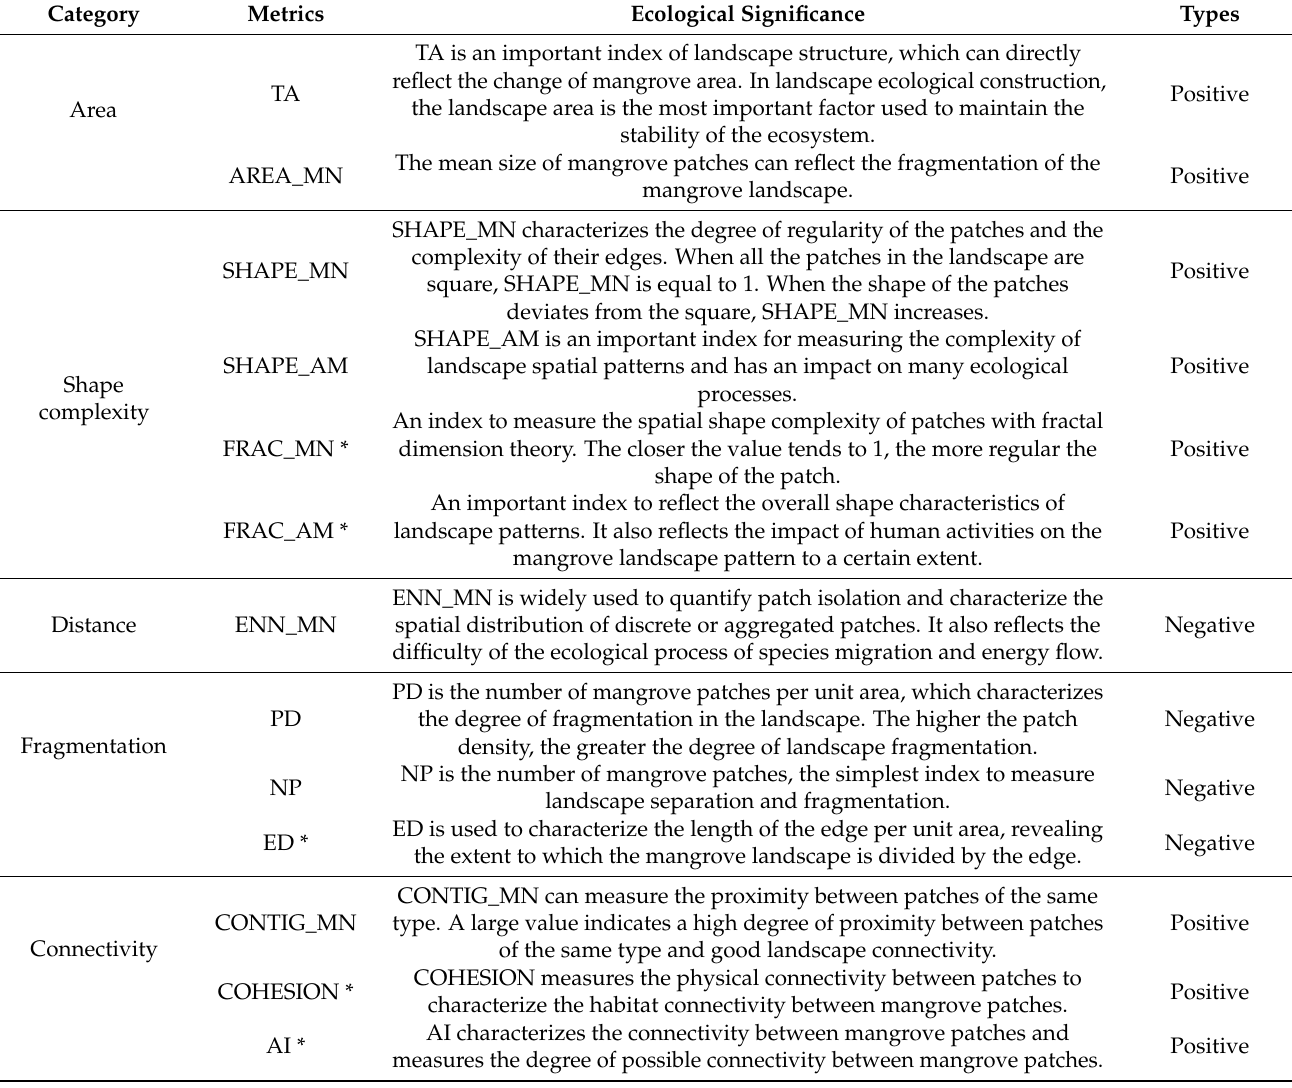
Table 3. Preliminary evaluation index system for landscape